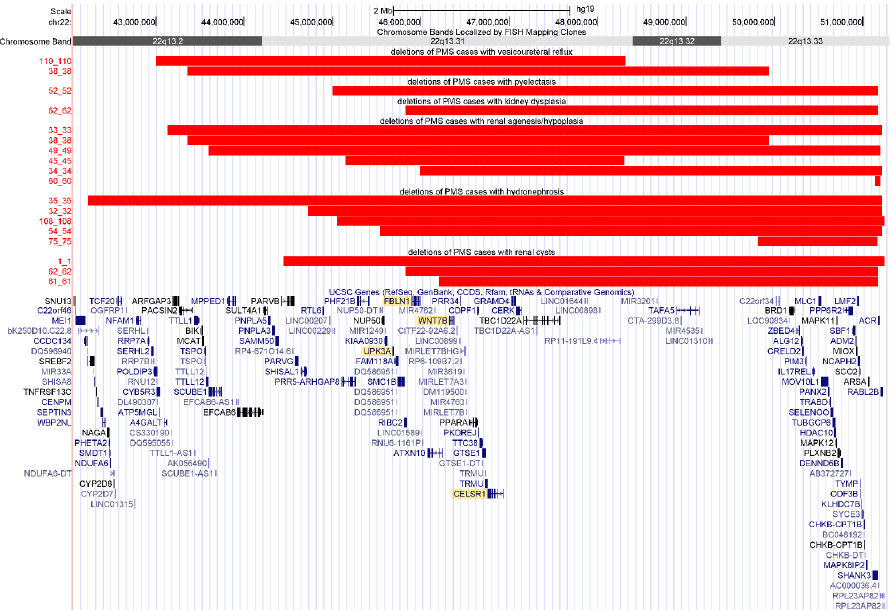
Figure 2. Deletions for individuals with PMS with renal disorders by type of disorder. Figure created from UCSC Genome Browser [37,50]. Red bars show the deleted regions. Renal disorders of unspecified type are not shown. Genes highlighted in yellow are candidate genes for renal disorders in PMS. Table 4. Characteristics of the study population (n = 152) and association with deletion size means.